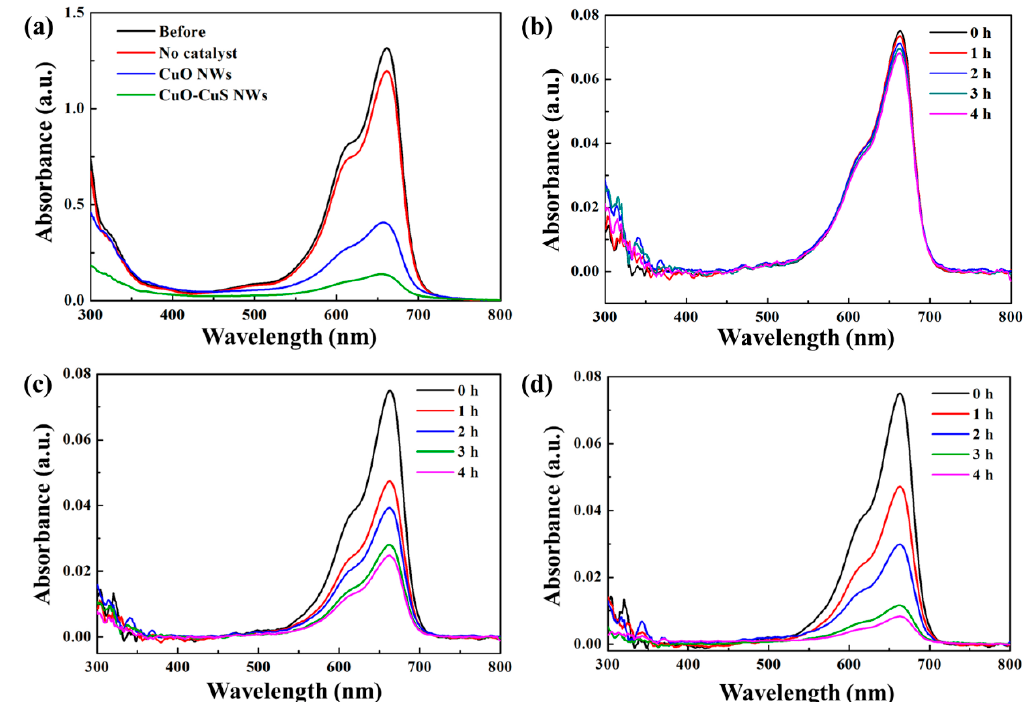
Figure 5. ( a ) UV-Vis absorbance spectra of MB aqueous solutions before and after 4 h visible light irradiation as well as UV-Vis absorbance spectra on MB degradation at different durations for ( b ) no catalyst ( c ) CuO nanowires ( d ) CuO-CuS core-shell nanowires.